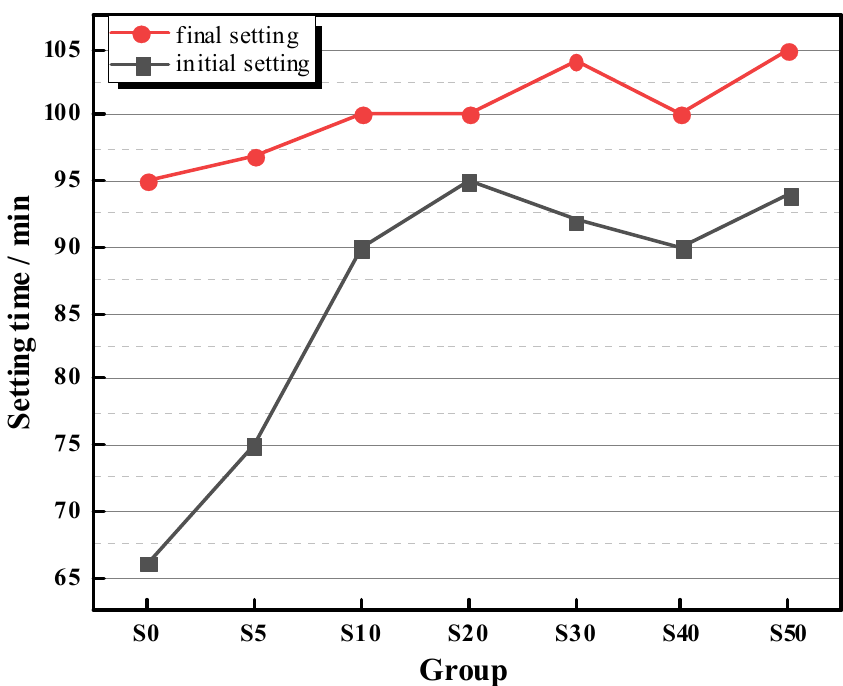
Figure 4. The setting time of AAS mortars with different dosages of SAPs .